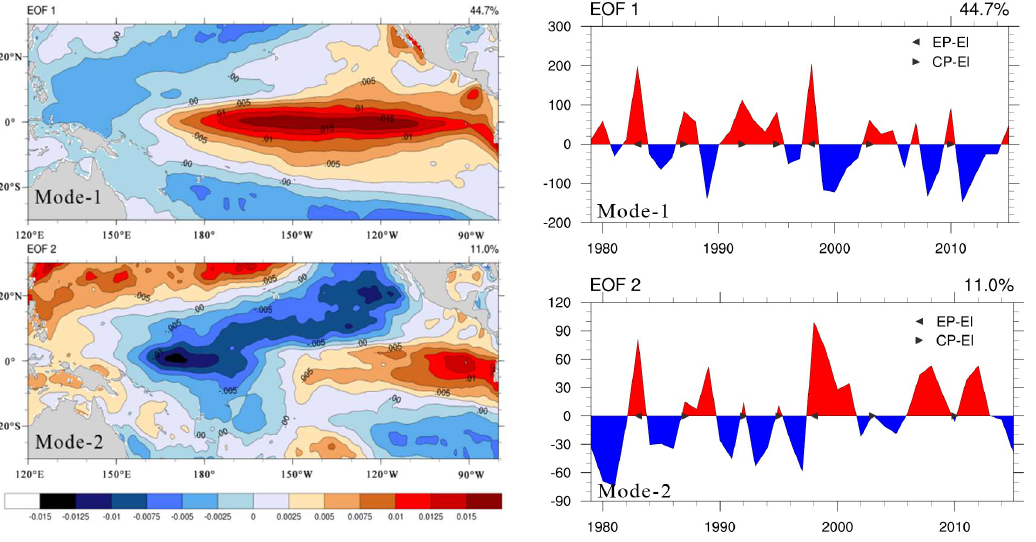
Figure 7. EOF analysis of the SST anomalies in the low latitudes of Pacific. Table 3. Variance contribution and eigenvalues of EOF analysis results for SST anomalies.